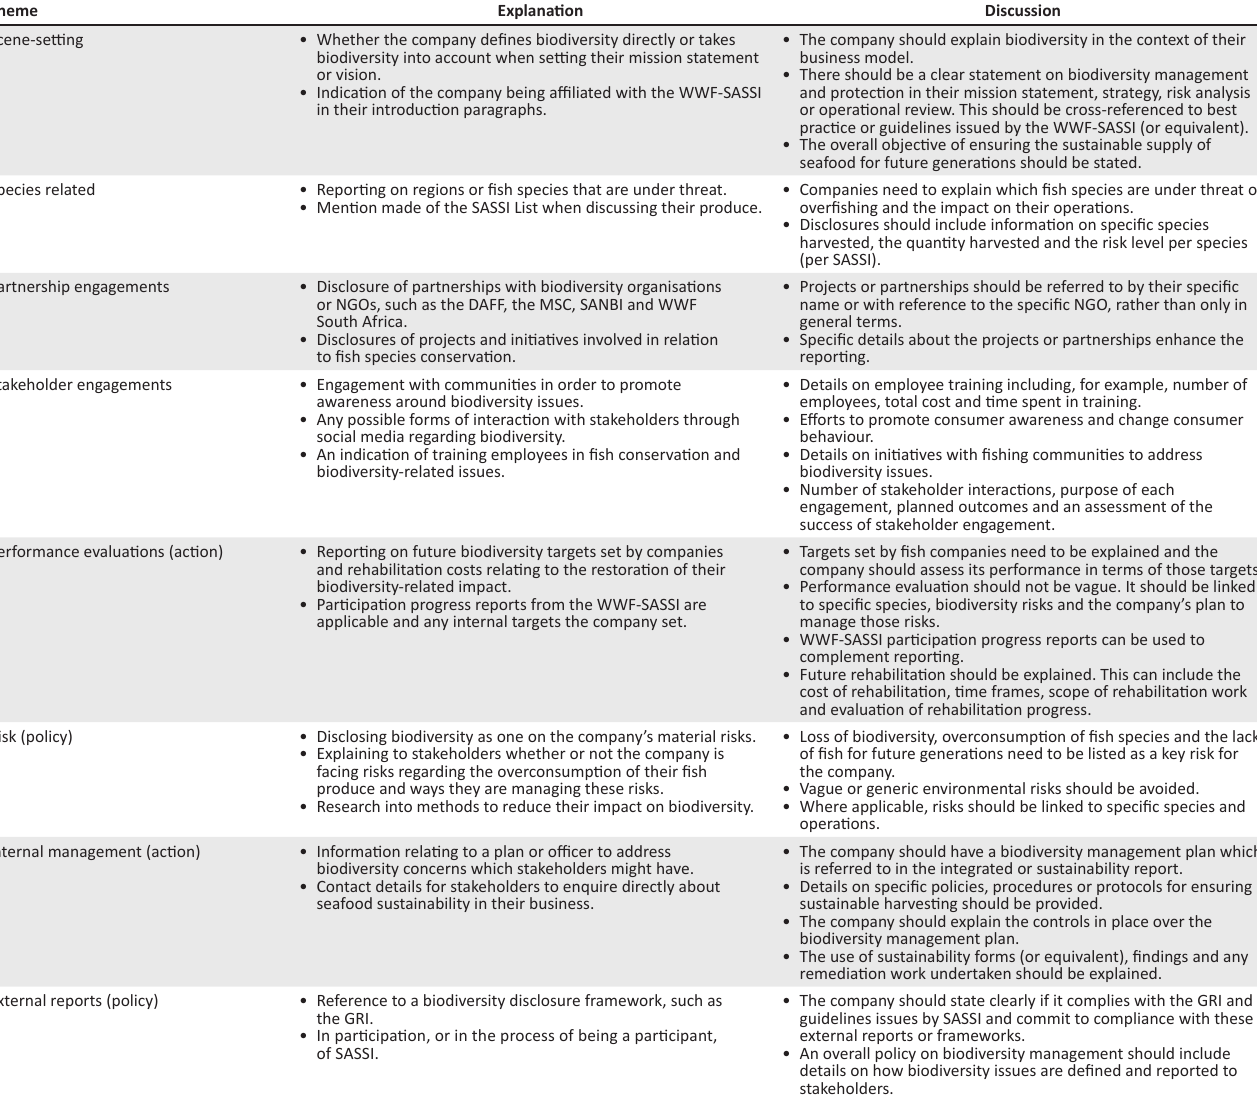
TABLE 2: Summary of disclosure